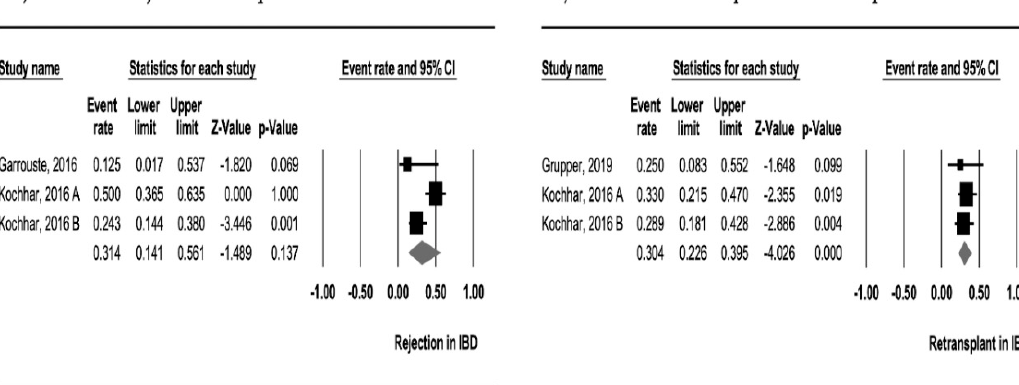
Table 2. Subgroup analyses.